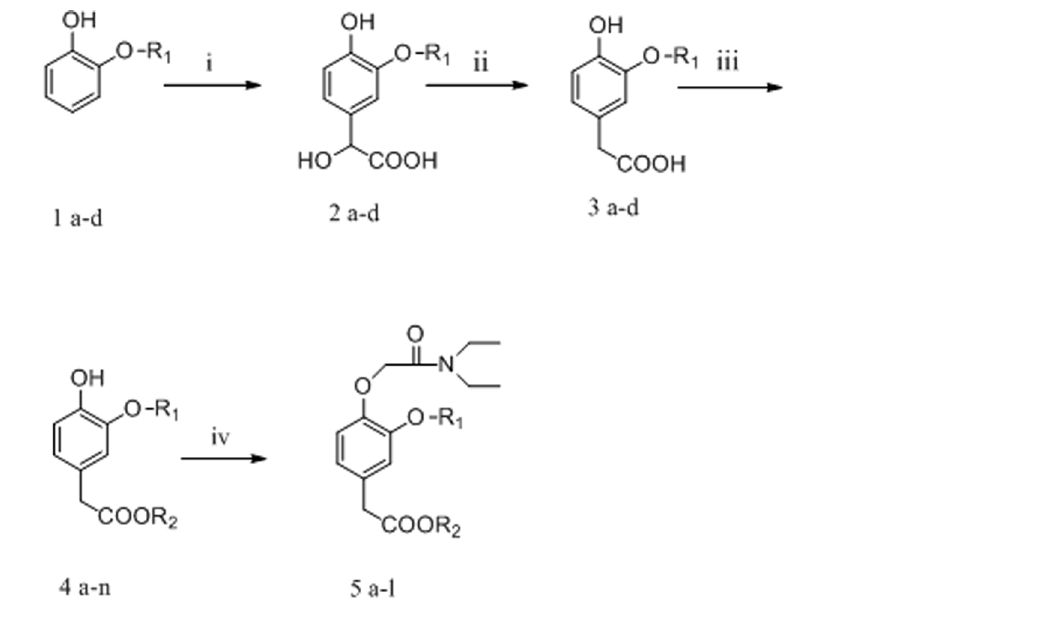
Figure 2. Synthesis of compounds 5a-l.